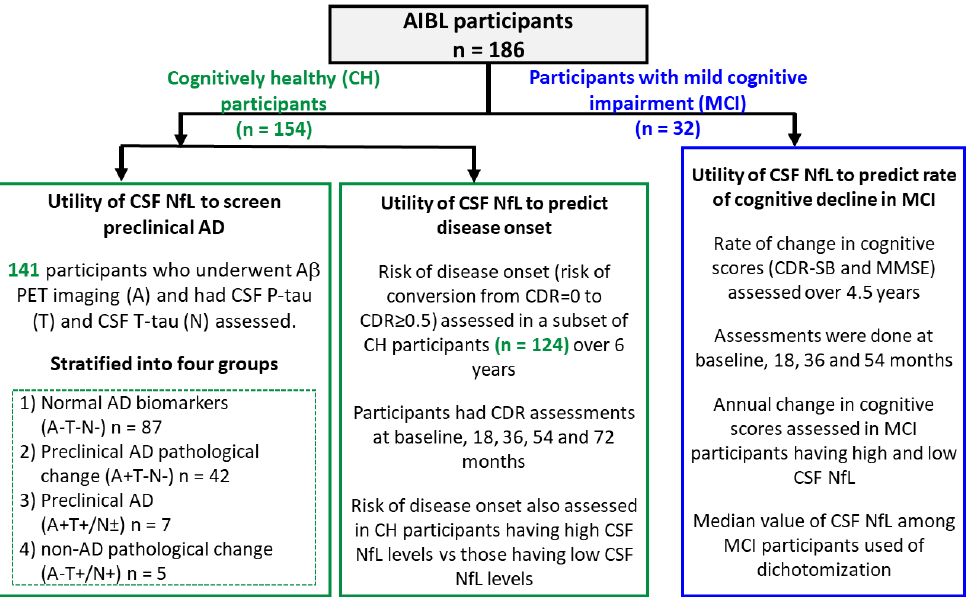
Figure 1. Outline of study protocol and design ATN refers to biomarkers of amyloid pathology (A), tau pathology (T) and neurodegeneration (N). Abbreviations: A β : amyloid- β ; CDR: Clinical Dementia Rating Scale; CDR-SB: Clinical Dementia Rating–Sum of Boxes; CSF: cerebrospinal fluid; MMSE: Mini Mental State Examination; NfL: neurofilament light; PET: positron emission